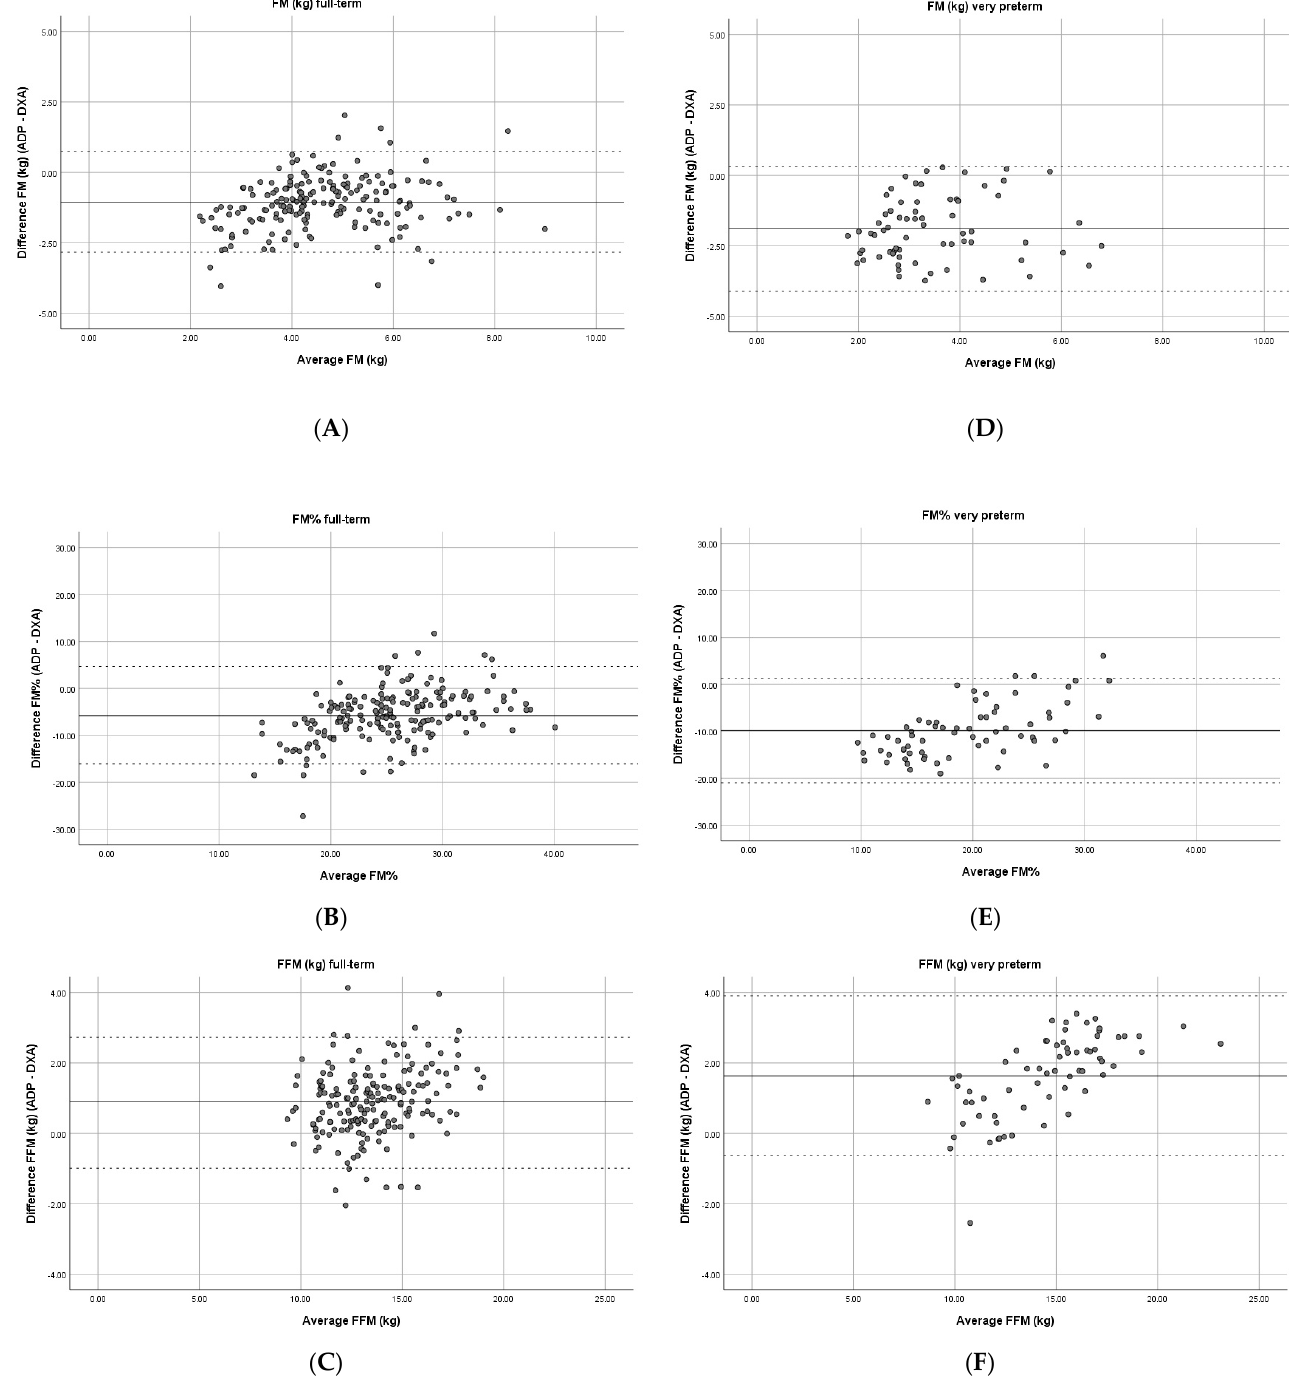
Figure 1. Bland – Altman plots for FM, FM%, and FFM measured by ADP and DXA in full-term ( A – C ) and very preterm-born children ( D – F ) aged 3–5 years: Continuous line represents the mean difference between ADP and DXA. The dashed lines represent the limits of agreement. Abbreviations: FM, fat mass, FM%, fat mass percentage, FFM, fat-free mass; kg, kilograms; DXA, dual-energy X-ray absorptiometry; ADP, air-displacement plethysmography.